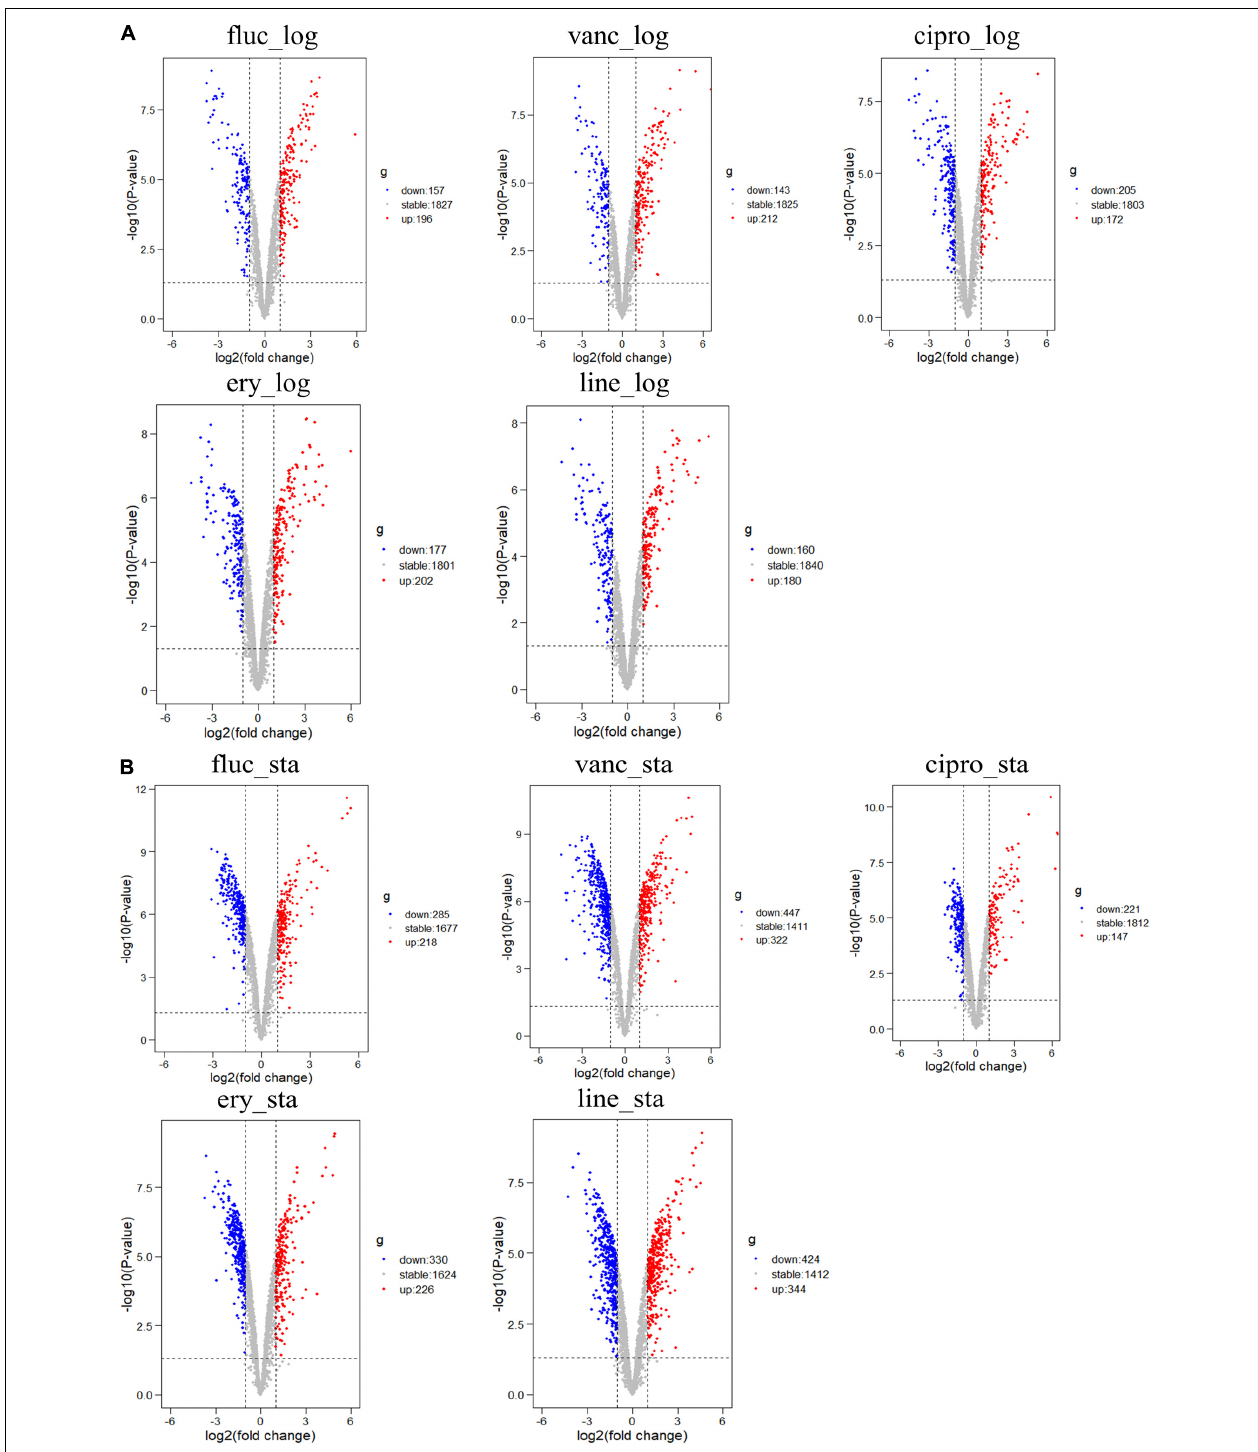
FIGURE 2 | Differential expression of five different antimicrobials treated samples in logarithmic phase and stationary phase. (A) DEGs in logarithmic phase (B) DEGs in stationary phase. The red points represent upregulated genes screened based on log2 fold change > 1 and a corrected p < 0.05. The blue points represent the downregulation of the expression of genes screened based on log2 fold change < –1 and a corrected p < 0.05. The gray points represent genes with no significant differences.